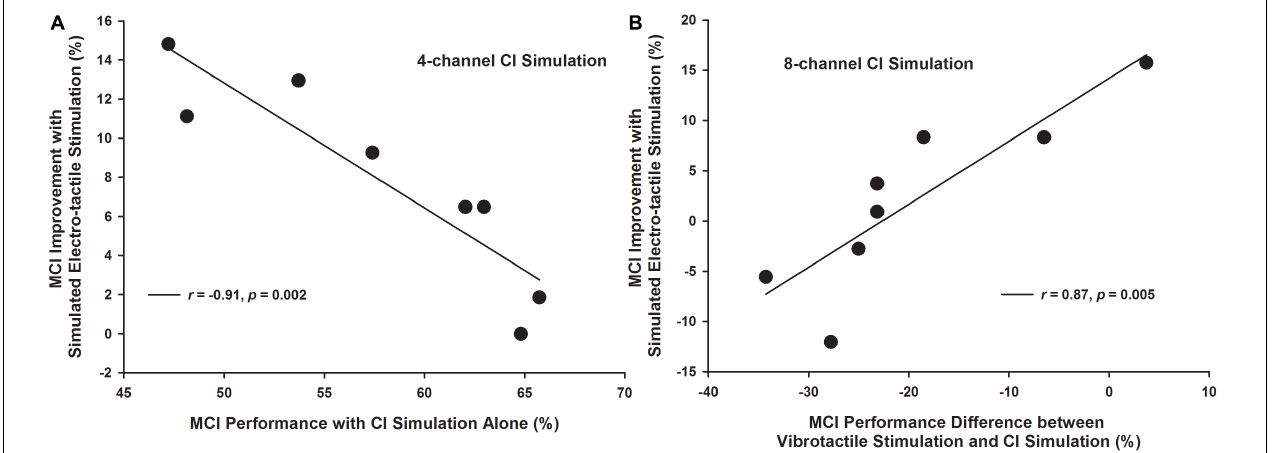
FIGURE 7 | Melodic contour identification improvement with simulated electro-tactile stimulation as a function of the melodic contour identification performance with CI simulation alone ( A: 4-channel CI simulation) and as a function of the melodic contour identification performance difference between vibrotactile stimulation and CI simulation ( B: 8-channel CI simulation). Each line shows a linear regression with the corresponding correlation coefficient r- and p -value listed in the figure